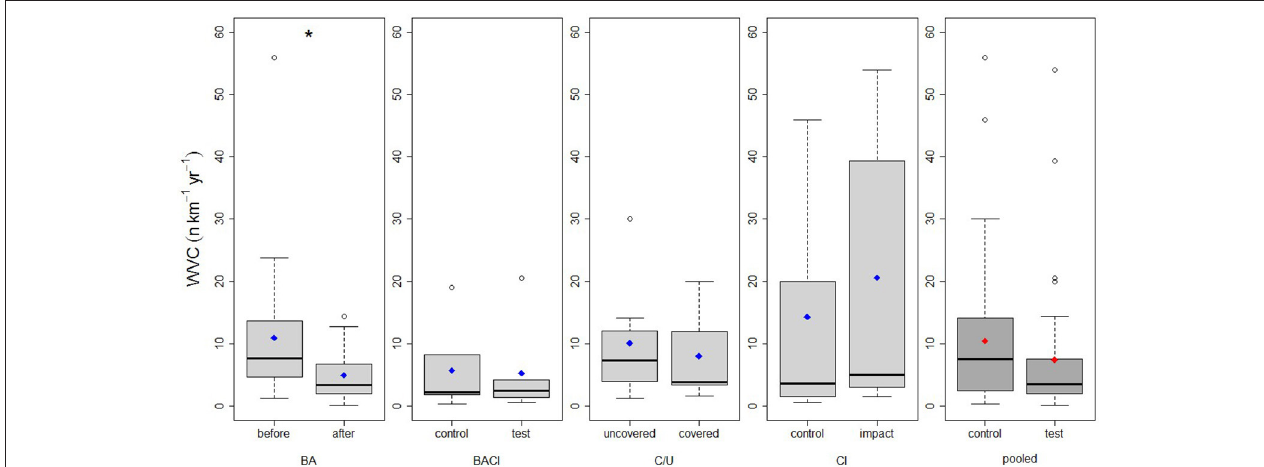
FIGURE 2 | Boxplots showing the influence of Wildlife Warning Reflectors (WWR) on Wildlife-Vehicle collisions (WVC) with respect to the study design. Data was standardized to WVC year − 1 km − 1 for both with and without reflectors. Studies performing a before-after (BA) comparison showed a significant reduction in WVC-data ( p < 0.05). Before-after control-impact (BACI), covered/uncovered studies (C/U), as well as control-impact (CI) studies, did not show any significant effect of WWR on WVC-data. All standardized data comparing WVC year − 1 km − 1 for both, with and without reflectors WVC did not show any significant effect of WWR on WVC-data